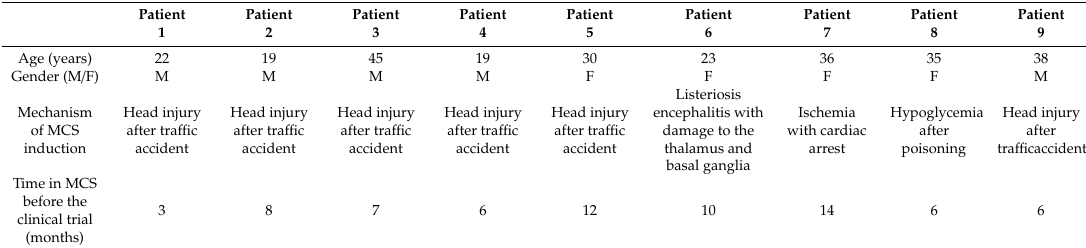
Table 1. Clinical and demographic characteristic of nine patients in minimally conscious state (MCS) in treatment with bone marrow-derived mesenchymal stem cells. The table contains data on age, sex, mechanism of injury, and length of time in the state of minimal consciousness from the time of injury to the start of experimental